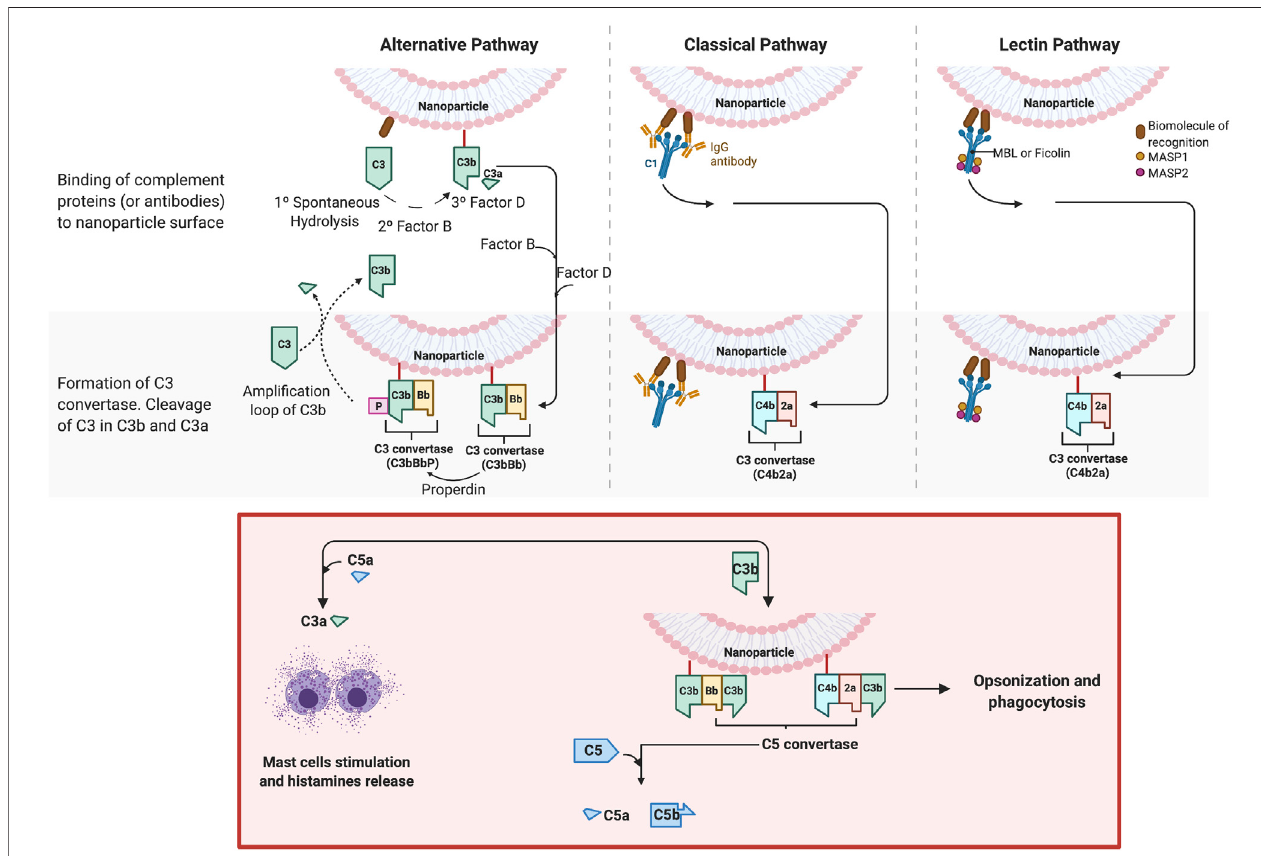
FIGURE 6 | Complement activation by nanoparticles. The activation of the complement cascade occurs via three different mechanisms: the classical, alternative and lectin pathways. The classical and lectin pathway is initiated bythe recognition ofpatterns on the particlesurface by soluble mediators in the blood. Forthe classical pathway,themediatorsareantibodies,IgGorIgM.TheFcportionoftheseantibodiesisrecognizedbythecomplementcomponentC1,whichincludesC1q(recognition protein) associated with the proteases C1r and C1s. The binding leads the production of C3 convertase (C4b2a) (central panel). For the lectin pathway, the C3 convertase also is produced, but in this case, the recognition is carried out through other mediators, lectins, which recognizes sugars (mainly N-acetyl glucosamine and mannose). In humans, fi ve different lectins that can initiate this pathway have been identi fi ed: MBL, M-, L-, and H- fi colins, and collectin 11 (CL11 or CL-K1), which are associated with other proteins, such as MASP-2 and MASP-1 (right panel). The synthetized C3 convertase cleaves the abundant serum protein C3 into C3a and C3b. Later, a larger fragment, C3b, is covalently attached to the surface. On the other hand, when the spontaneous hydrolysis of the thioester bond in the protein C3 takes place, the alternative pathway (left panel) is initiated. C3(H20) is thus produced, which binds to the factor B, another plasma protein, to form C3(H20)B. The latter is cleavage by the factor D, producing the convertase C3(H20)Bb, also called fl uid-phase C3 convertase, which will cleave C3 in C3a and C3b. In turn, this forms C3b, whichbindstofactor Band then, inturn,iscleaved byfactor D,forming C3bBb.C3bBb isstabilizedbyanother complementprotein, knownasproperdin(P), andforms the convertase C3bBbP, able to cleave C3 into C3a and C3b, establishing the ampli fi cation of more C3b that could bind on the particle (or pathogen) surface. C3(H2O) also can deposit (non-covalently) on surfaces and initiate C3 cleavage (Murphy et al., 2016; Moghimi and Simberg, 2017). The fi gure was prepared in